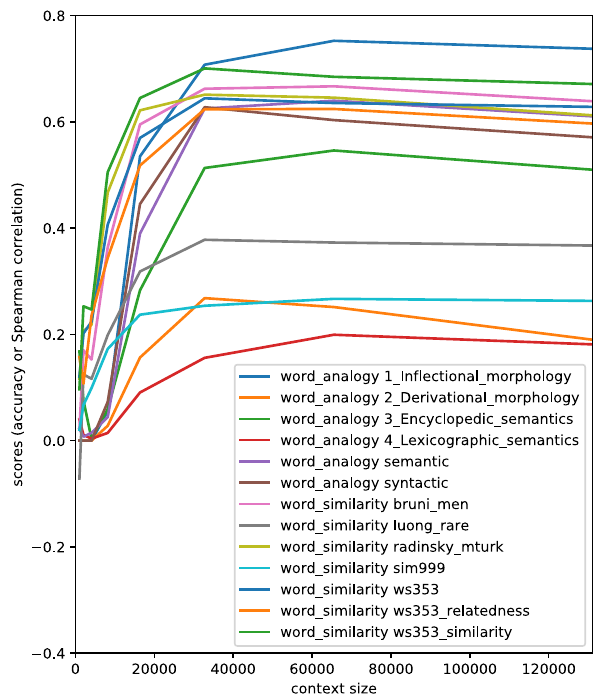
Fig. 14 Word similarity and word analogy scores with different con- text size